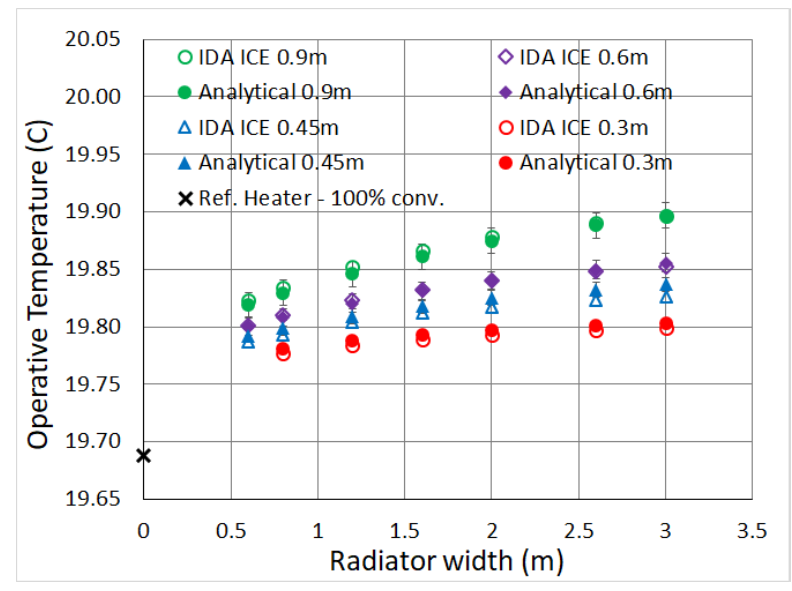
Figure 10. Operative temperatures for a 21-type panel radiator, with h = 0.3, 0.45, 0.6, 0.9